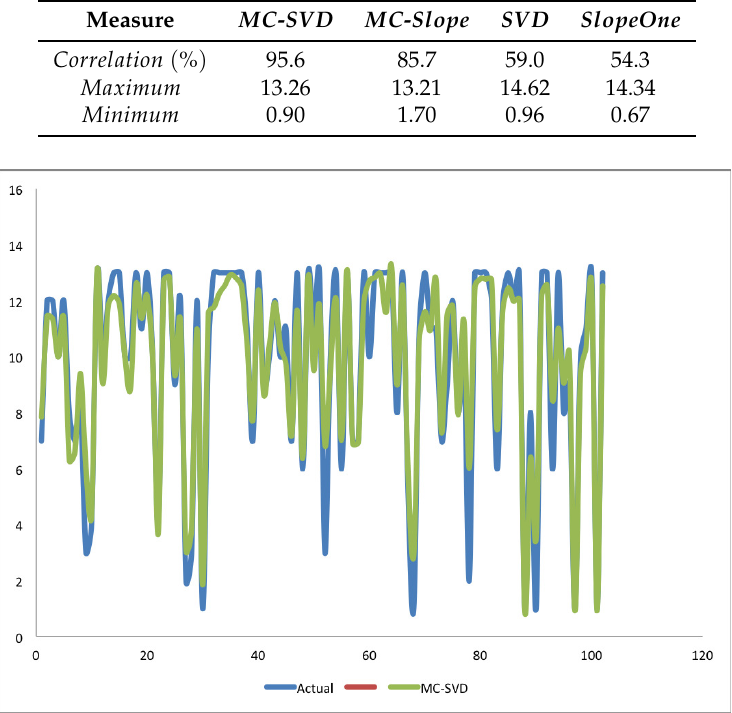
Figure 2. Graph of Actual vs. MC - SVD predicted